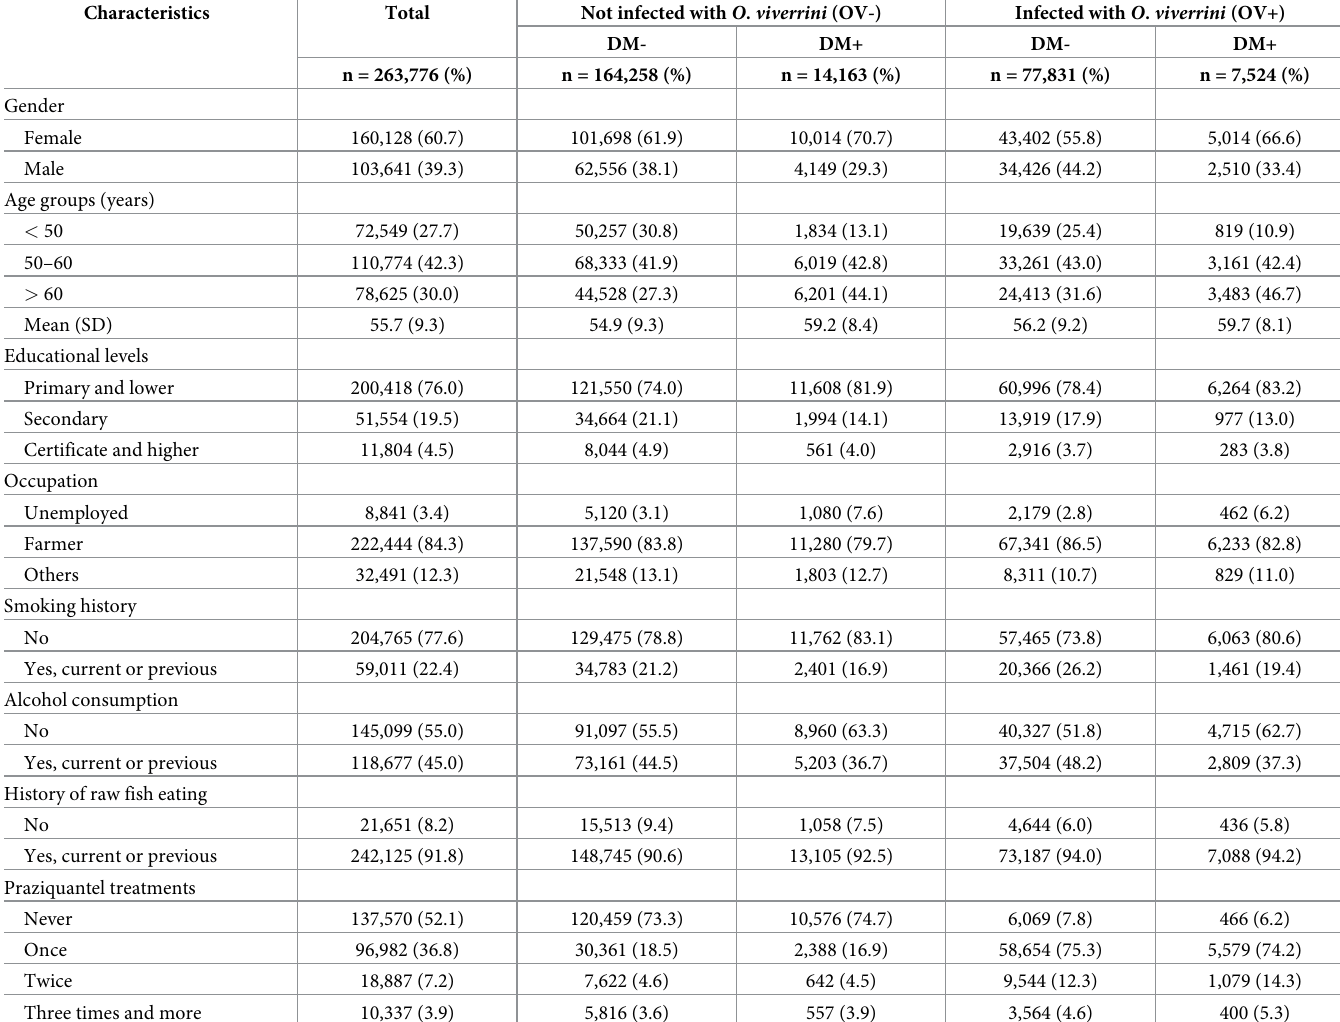
Table 1. Demographic characteristics of participants according to O . viverrini infection and diabetes mellitus status. The data are presented as frequencies and per- centages for the overall sample and separated by O . viverrini infection and diabetes mellitus status.